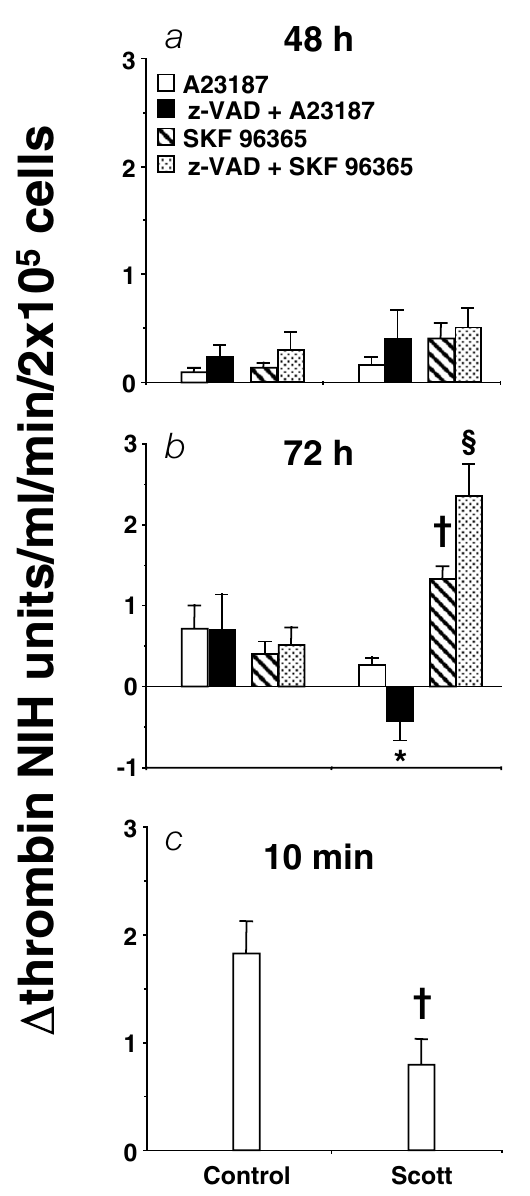
Figure 6 Procoagulant phosphatidylserine exposure measured by pro- thrombinase assay after apoptosis induction in control and Scott cells. Cells were treated for 48 (a) or 72 (b) h, by 200 nM A23187 or 10 µ M SKF 96365 in the absence or in the presence of z-VAD.fmk (50 µ M), or for 10 min ( c ) by 1 µ M A23187, as described in the "Experimental Procedures". Data are expressed as mean ± SEM of 5 independent experiments (each with duplicate samples), where (cid:1) represents the increase in activity with respect to baseline prothrombinase activity. * P < 0.05 versus 72 h A23187 treatment of Scott cells. §P < 0.05 versus the corresponding value obtained in the absence of z-VAD.fmk. † P < 0.05 versus the correspond- ing value obtained with control cells.